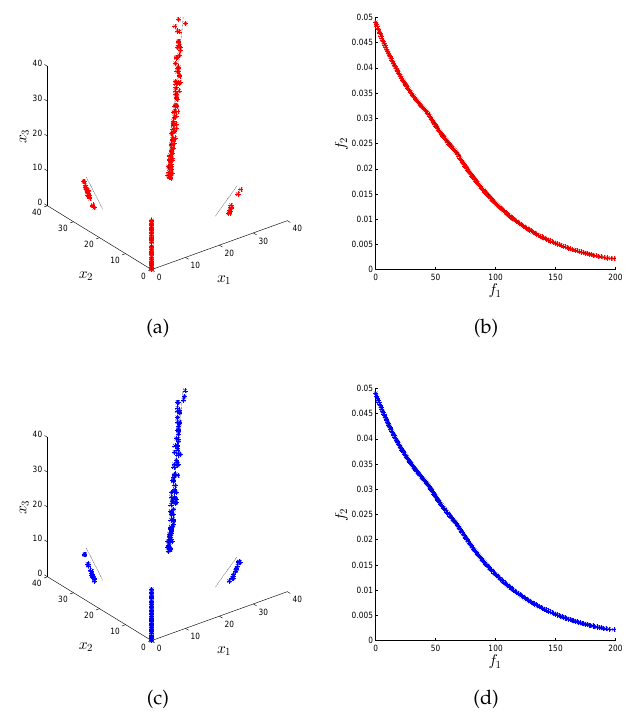
Figure 6. Graphical results of the run with the median values for the SCM1 function for the SMS-EMOA algorithm. ( a ) Decision Space Original; ( b ) Objective Space Original; ( c ) Decision Space VR; ( d ) Objective Space VR.